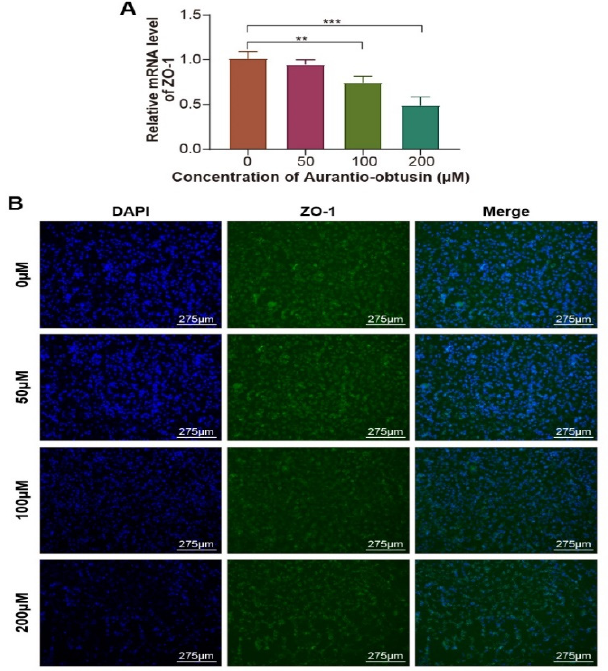
Figure 4. Expression of ZO-1 in HRGECs after exposure to AO. The cells were treated with AO (50 to 200 µM). ( A ) Real-time quantitative PCR analysis. ( B ) Immunofluorescence staining analysis. ZO- 1 (green), DAPI (blue). The data are presented as means ± standard deviation. n = 3, ** p < 0.01, *** p < 0.001.